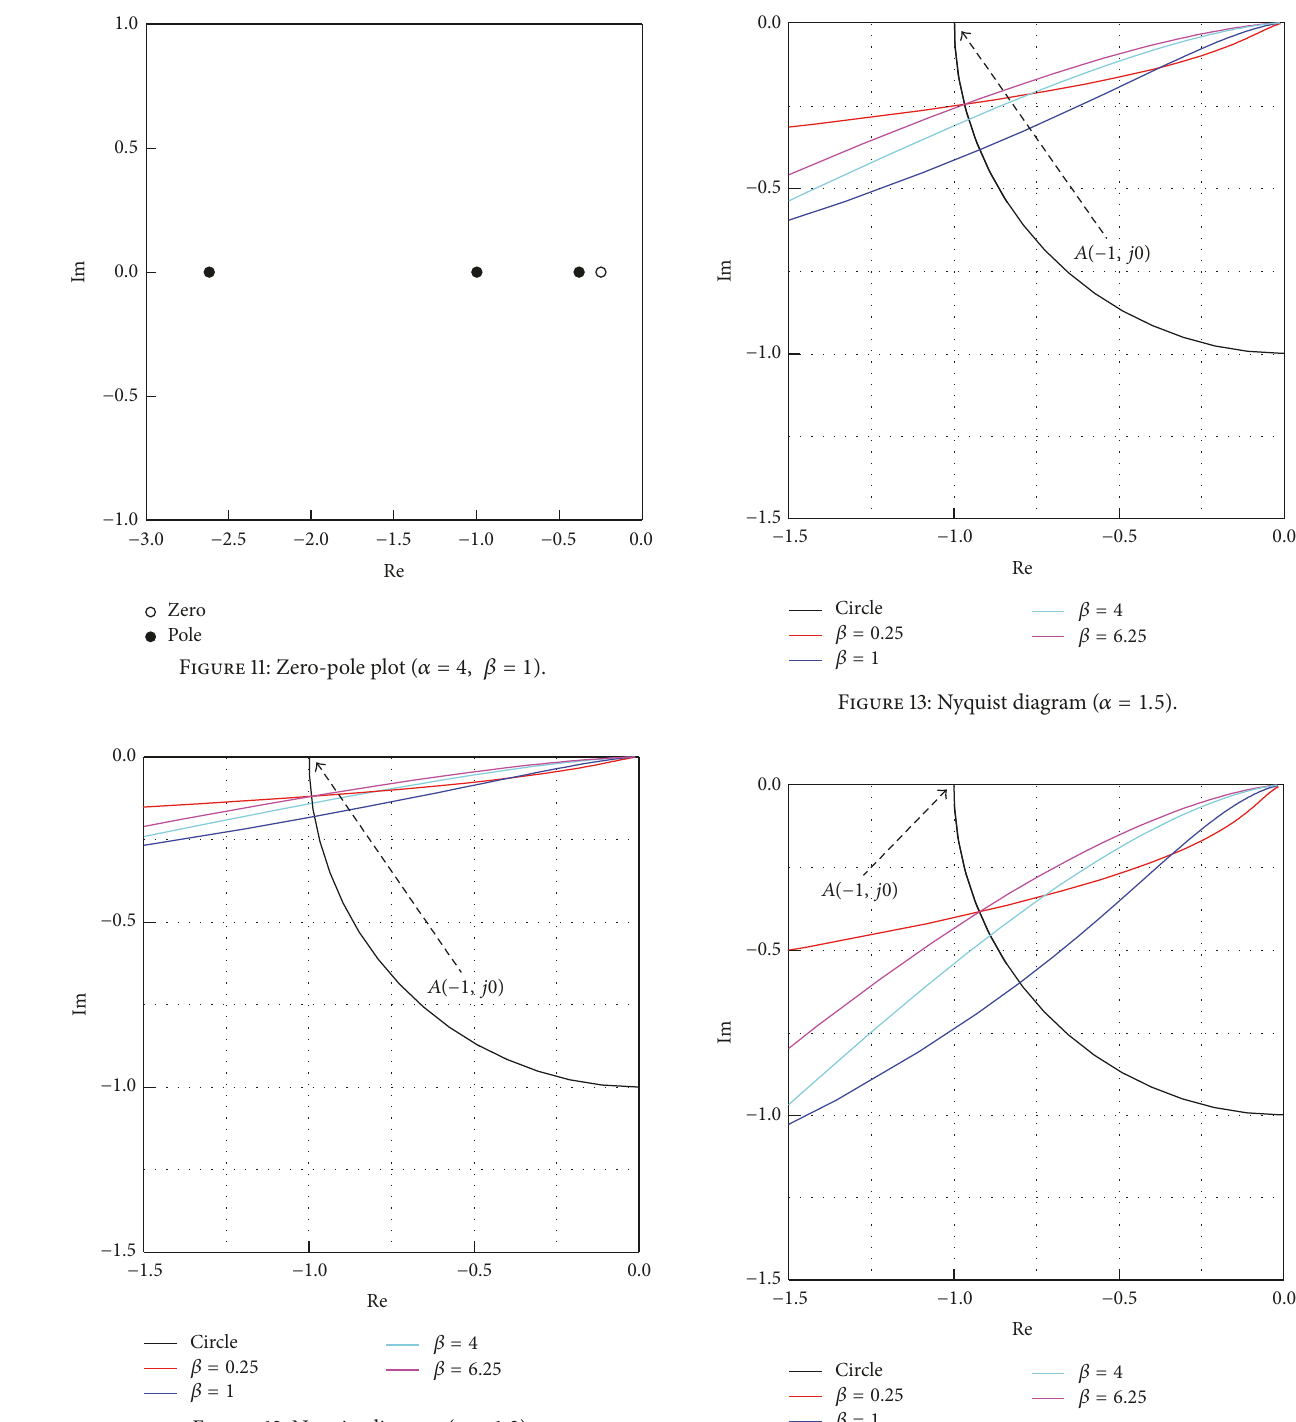
Figure 12: Nyquist diagram ( 𝛼 = 1.2 ).